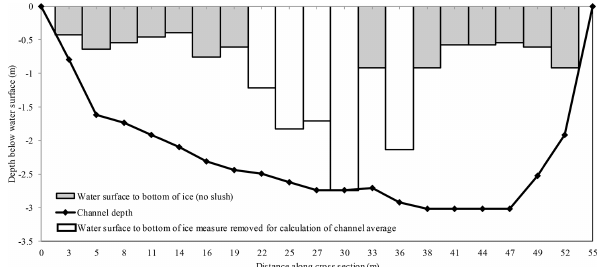
Figure 10. A bar plot of the 19 water surface to bottom of ice thick- ness measurements collected on 28 March 1978 at Nashwaak River below Durham Bridge (01AL002). The hydrometric survey note in- dicates that the measurement, at 30m river cross section distance is slush to bottom. Visual examination of this plot reveals 4 other mea- surements (shown with white fill) that likely include slush. These 5 measurements are removed when calculating average river ice